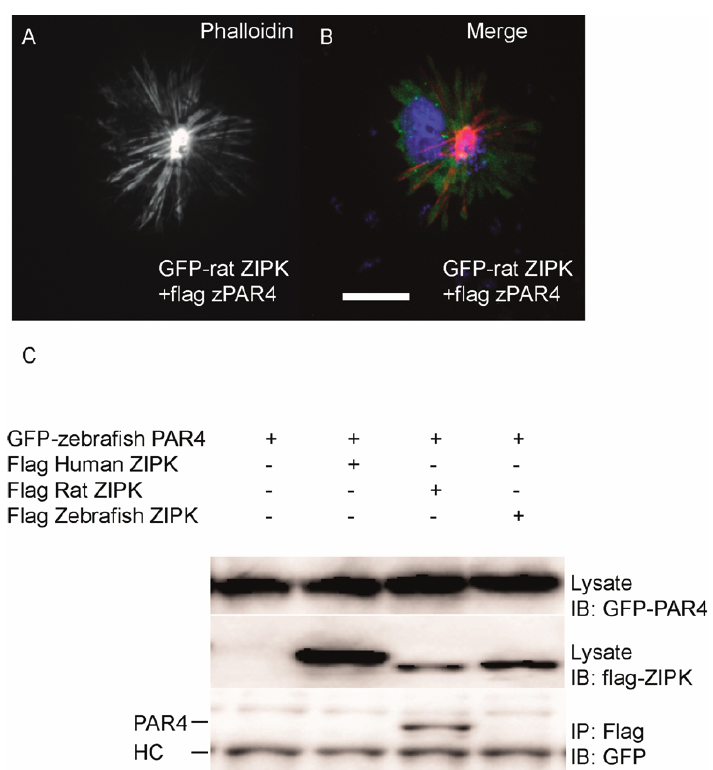
Figure 6. Differential interaction of ZIPK homologs with zebrafish PAR-4. HeLa cells were transfected with rat GFP-ZIPK and flag zebrafish PAR-4 ( A , B ). The cells were fixed and stained with DAPI and Alexa 568-phalloidin. Black and white images show phalloidin staining, while color images are a merge of DAPI (blue), GFP (green), and phalloidin (red). White bar indicates a 20 μ m scale; ( C ) HEK293T cells were co-transfected with GFP-tagged zebrafish PAR-4 along with flag-tagged ZIPK from human, rat and zebrafish. Protein complexes were immunoprecipitated with anti-FLAG antibodies. The IPs were immunoblotted with anti-GFP antibodies and anti-FLAG antibodies. HC indicates the IgG heavy chain which is the same size as zebrafish and mouse ZIPK, while human is slightly heavier. Each experiment was repeated a minimum of three